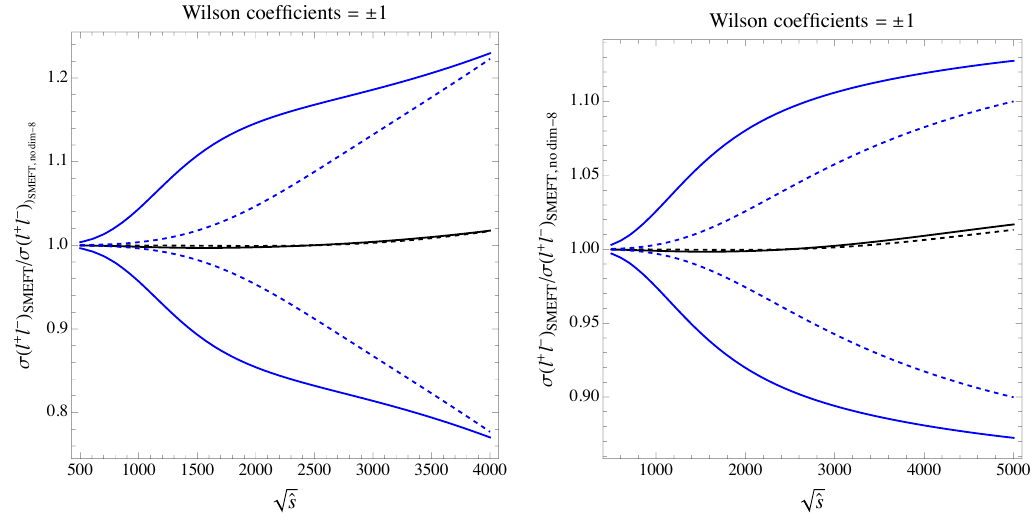
√ ˆ s relative to the O (1 / Λ 4 ) Figure 7 . Dimension eight contributions to pp → ‘ + ‘ − as a function of result from dimension six operators alone. In the black line we show the ratio with all coefficients set to +1 while in the blue lines show the ratio when the coefficient signs have been chosen to maximize (upper curve) or minimize (lower curve) eq. (B.8). The solid lines assume a new physics scale of Λ = 5 TeV, while the dashed line assumes Λ = 10 TeV. The difference between the left and right panels is the assumption about the dimension six coefficient signs, as in figure 5.